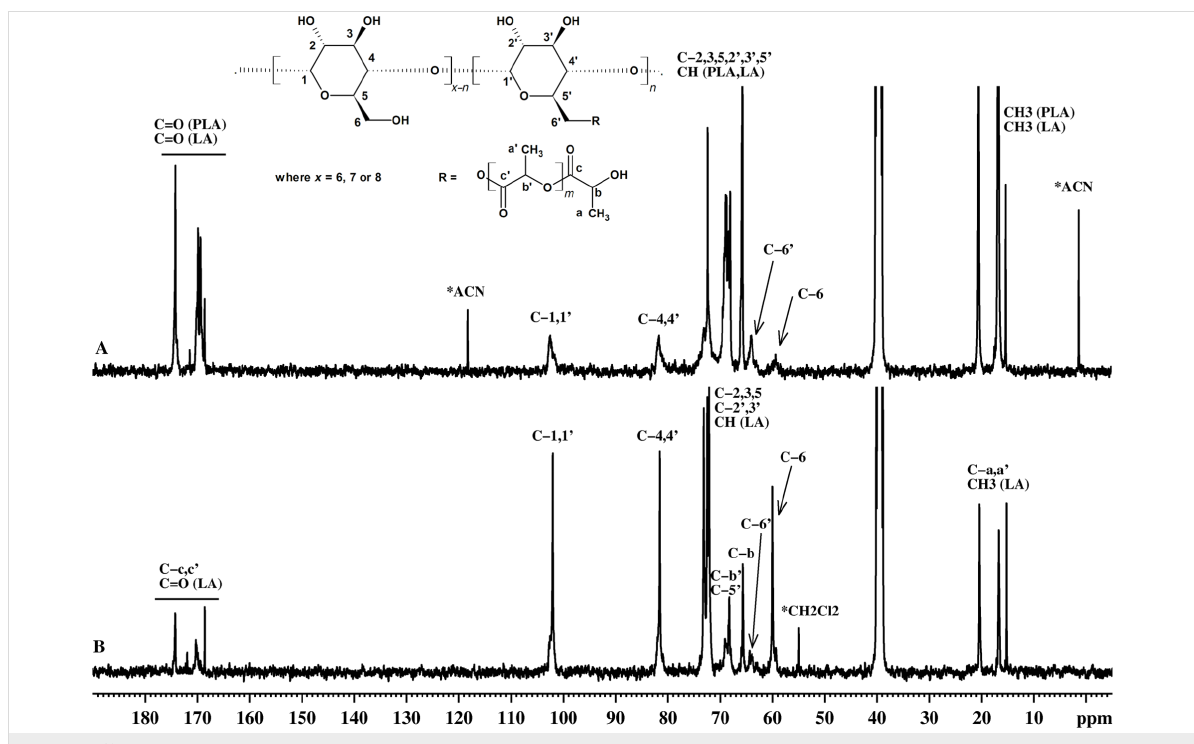
Figure 5: 13 C NMR spectra of (A) β -CD-LA F2 fraction and (B) β -CD-LA F1 fraction.